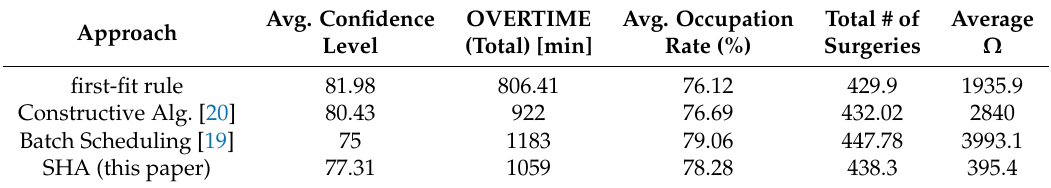
Table 4. Comparison of the one and the half years scheduling using different chain-constrained approaches with a minimum confidence level of